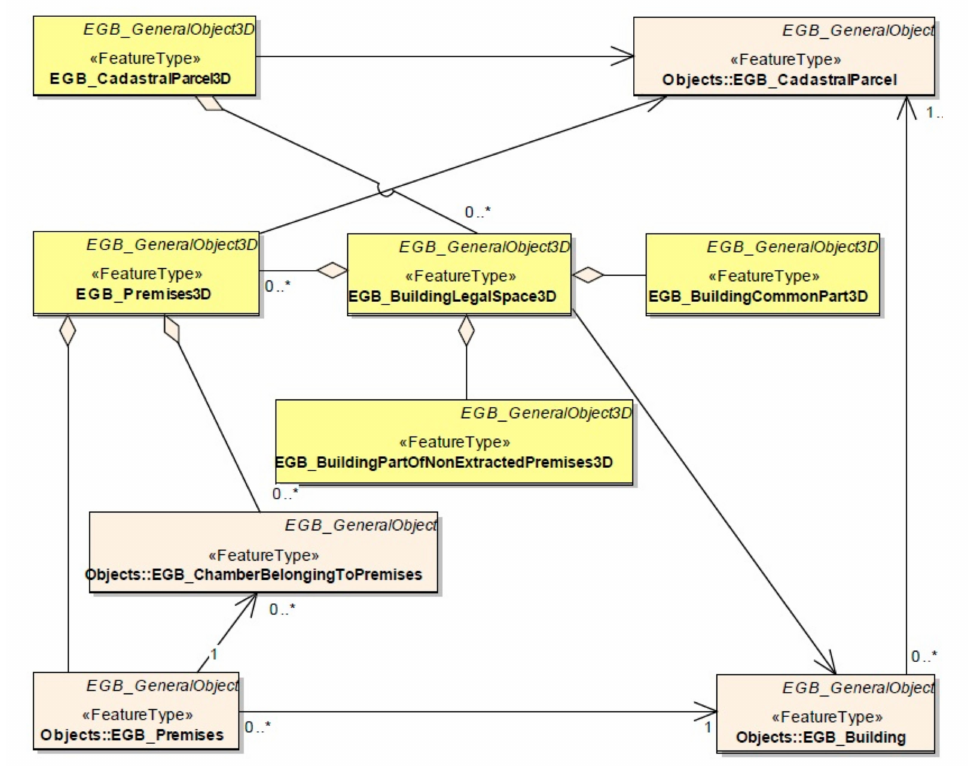
Figure 8. Diagram of ‘Premises3D’ defining relationships between 3D premises with traditional cadastral objects and proposed 3D